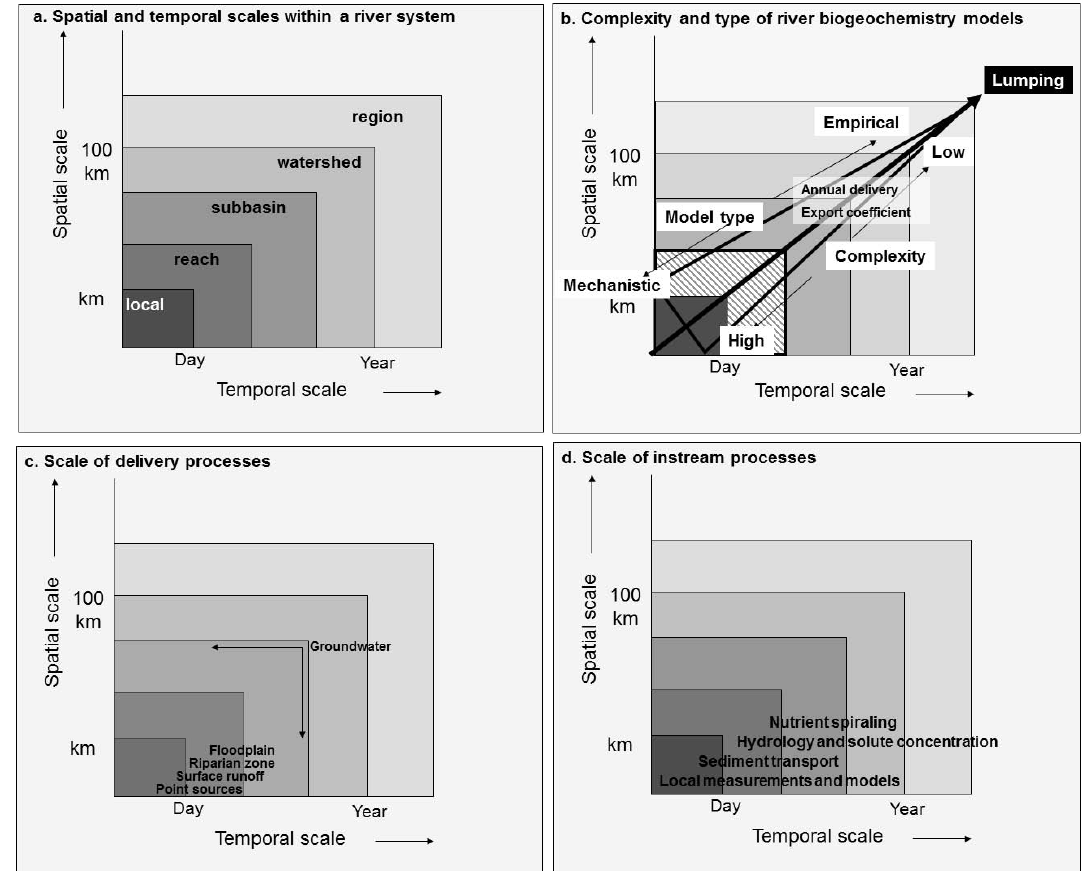
Fig. 2. Scheme of spatial and temporal scales (a) within a river system, (b) complexity and type of model within these domains, increasing complexity of models when moving from the top right to the bottom left corner; lumped models with annual time scale are in the top right corner, and mechanistic models with a time step of days or less in the bottom left corner, (c) the scale of delivery and (d) the scale of in-stream